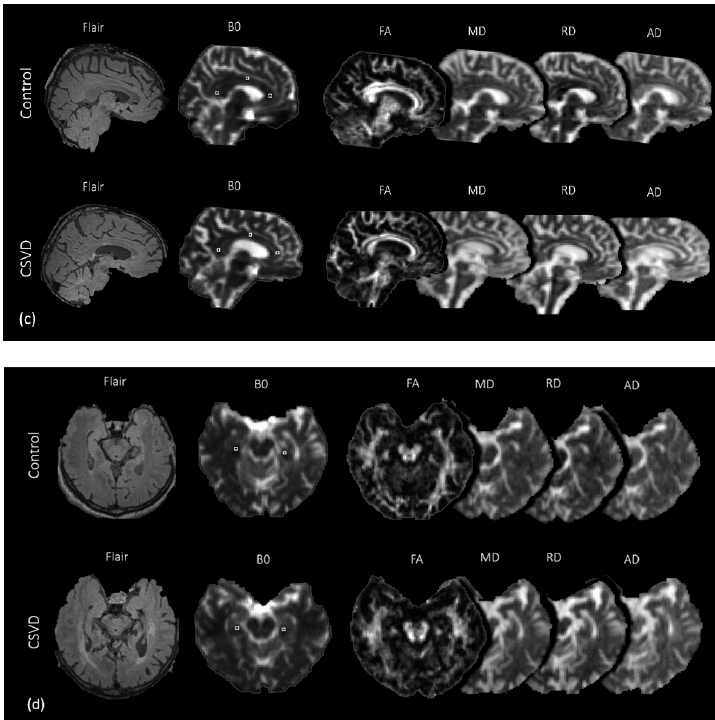
Figure A1. Selection of ROI in the periventricular (circle), deep (square), and juxtacortical (triangle) WMH and NAWM ( a ); anterior, mid-anterior, mid-posterior, and posterior CC ( b ); anterior, middle, and posterior CB ( c ); and hippocampi ( d ) on b0 images, followed by projection on 4 di ff usion metric maps (FA, MD, RD,